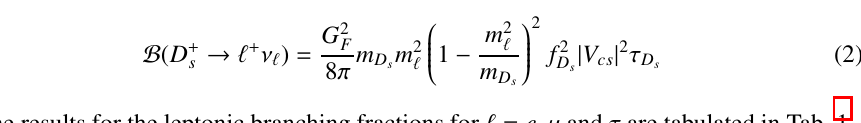
Table 1: Leptonic D +